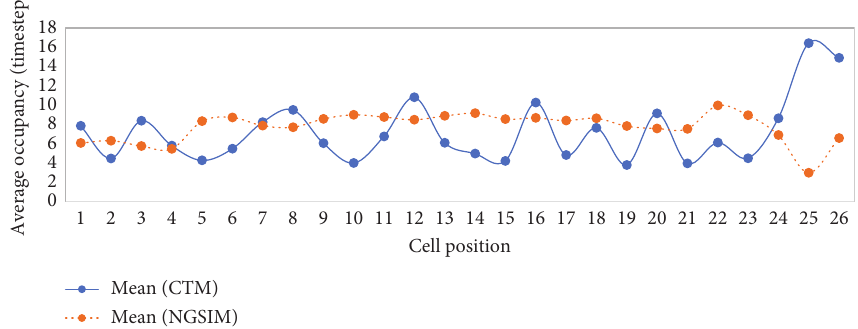
Figure 8: Case 4—comparison of the average occupancies/total time duration in each cell found between CTM and US-101.